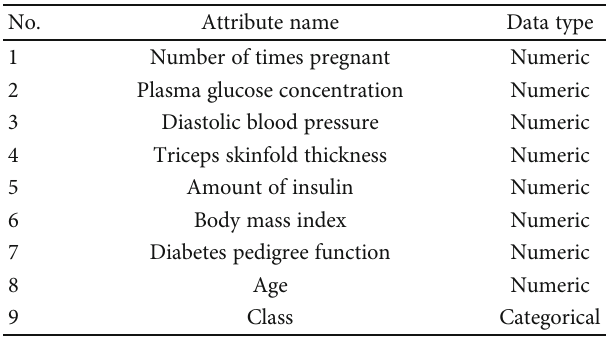
Table 2: The features of PIMA Indian